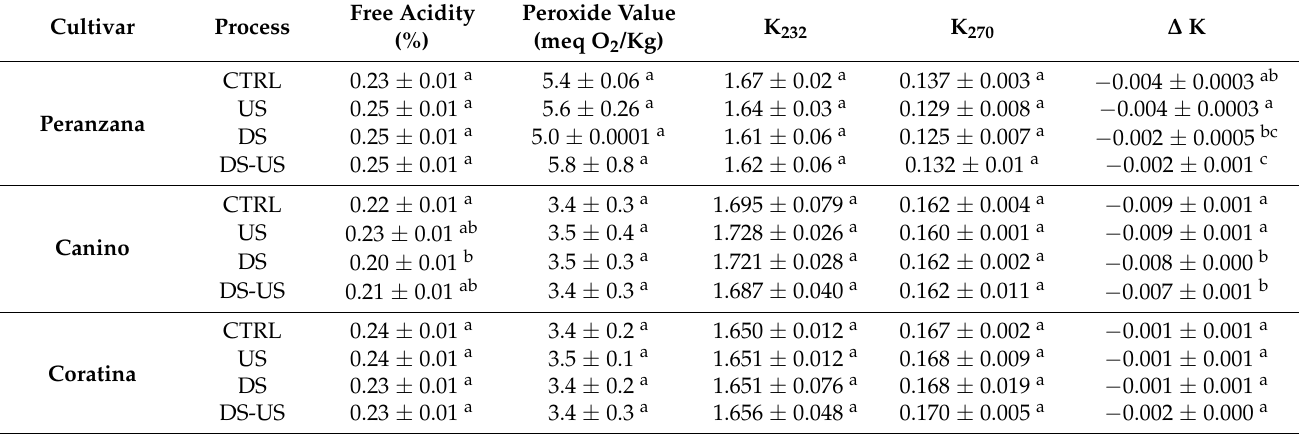
Legend: CTRL = hammer crusher without ultrasound treatment, US = hammer crusher and ultrasound treatment, DS = de-stoning machine without ultrasound treatment, and DS-US = de-stoning machine and ultrasound treatment; different letters in the same column indicate significant